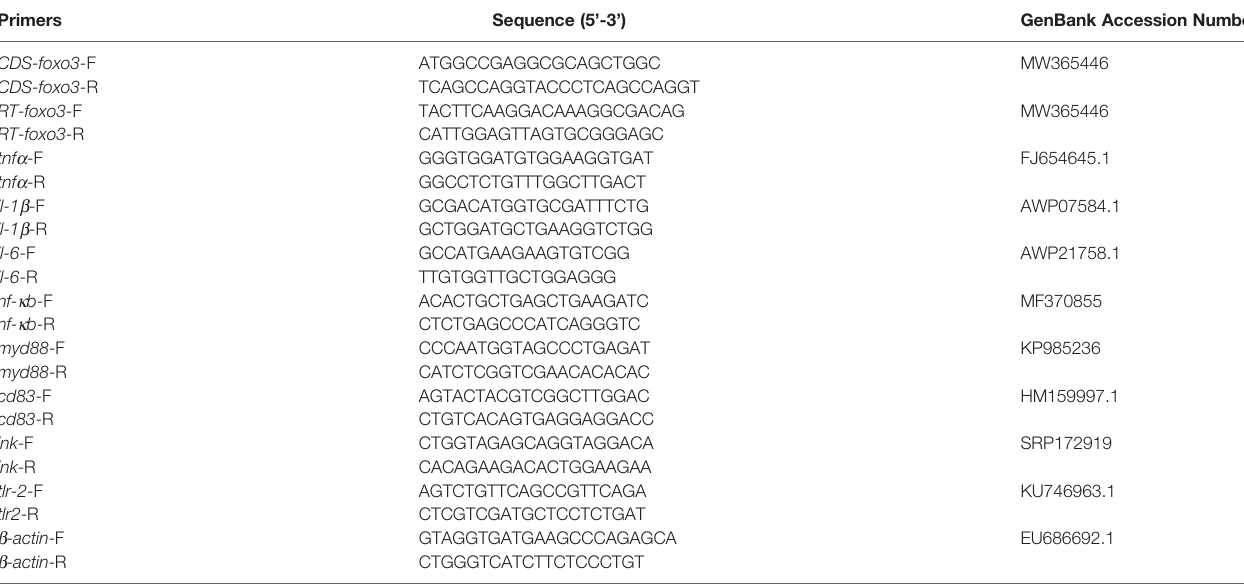
TABLE 1 | Sequences of the qPCR